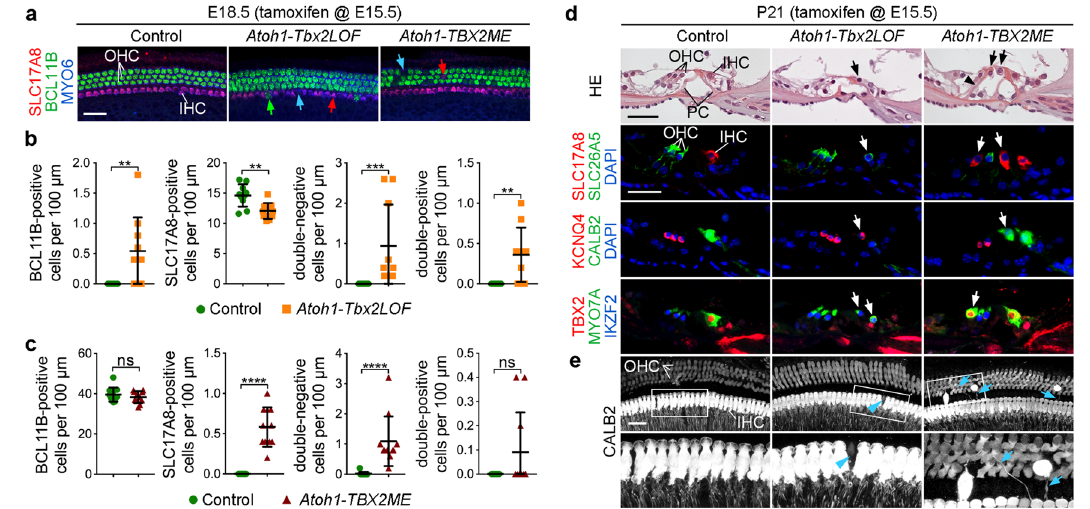
Fig. 5 | TBX2 cell-autonomously induces IHC fate in nascent hair cells. a – e AnalysisofhaircelldifferentiationinE18.5embryos( a – c )andP21mice( d , e )in which Tbx2 was ablated ( Atoh1-Tbx2LOF ) or misexpressed ( Atoh1-TBX2ME ) in indi- vidual hair cells by tamoxifen administration at E15.5. a – c (Co-)immuno- fl uorescence analysis of IHC and OHC differentiation in E18.5 whole cochleae by antibodiesagainstMYO6(allhaircells),BCL11B(OHCs),SLC17A8(IHCs).Redarrow points to MYO6 + /SLC17A8 + , green arrow to a MYO6 + /BCL11B + and blue arrow to a double-negative (SLC17A8 - /BCL11B - ) hair cell ( a ). (For single channels see Supple- mentaryFig.7b). b , c Quanti fi cationofhaircelltypesintheinnerrowofhaircellsin Atoh1-Tbx2LOF ( b ) and in the three outer hair cell rows in Atoh1-TBX2ME cochleae ( c ). Mean±standard deviation, two-sided unpaired t-test or Mann-Whitney-U test. ns,notsigni fi cant;** p <0.01;*** p <0.001;**** p <0.0001. n =10( b )and n =11( c )for eachgenotype. d Histologicalanalysis( fi rstrow)andimmuno fl uorescentdetection (second to fourth row) of markers for all hair cells hair (MYO7A), IHCs (SLC17A8,